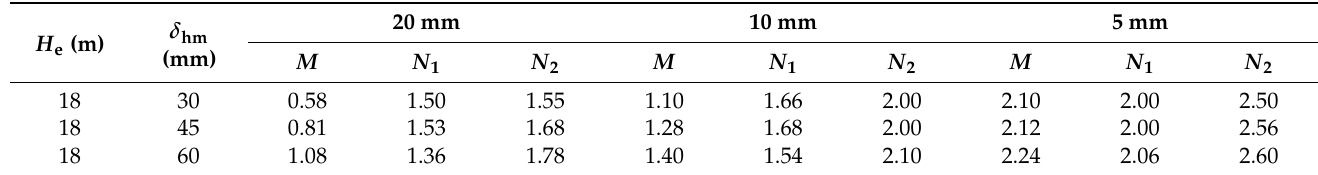
Table 4. Determination parameters of the influenced zones of deep excavation [27].